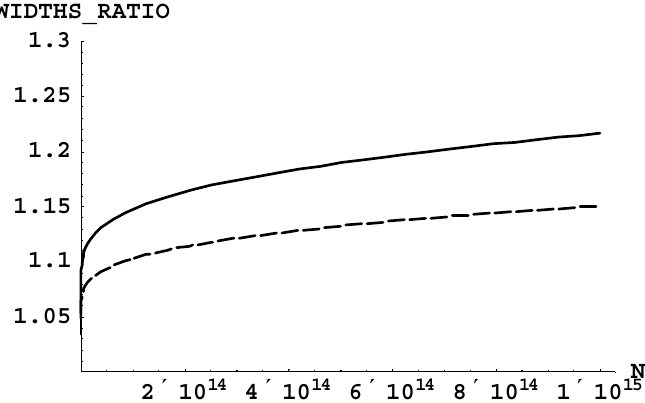
Figure 2. The ratio of the ion dynamical Stark width with the allowance for the center-of-mass motion to the ion dynamical Stark width from the conventional theory [29] versus the electron density N e (cm − 3 ) for the H α line emitted from a hydrogen plasma at T = 1 eV for C = 2 (solid line) and for C = 3/2 (dashed line) [17]. Plasma parameters correspond to edge plasmas of magnetic fusion machines and to atmospheres of flare stars.